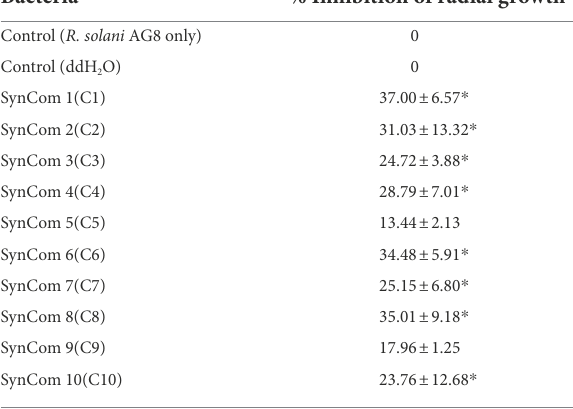
TABLE 2 Inhibition of SynComs on the radial growth of R. solani in dual-culture assays.